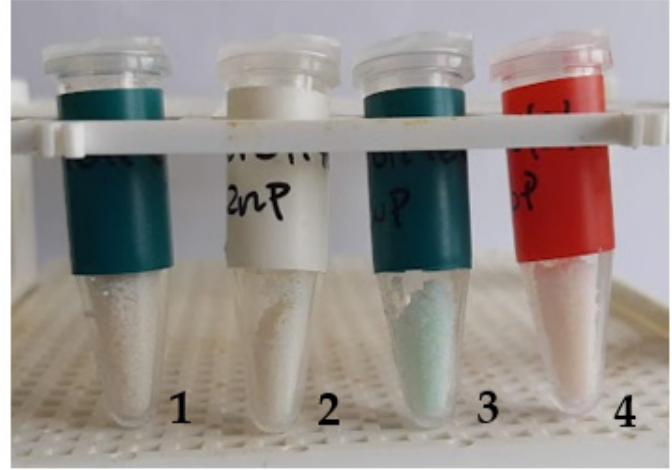
Figure 3. Purolite C18-TLL (1) unmodified, modified with (2) ZnCl 2 /sodium phosphate, (3) CuCl 2 /sodium phosphate, and (4) CoCl 2 /sodium phosphate. Other specifications are described in Methods.